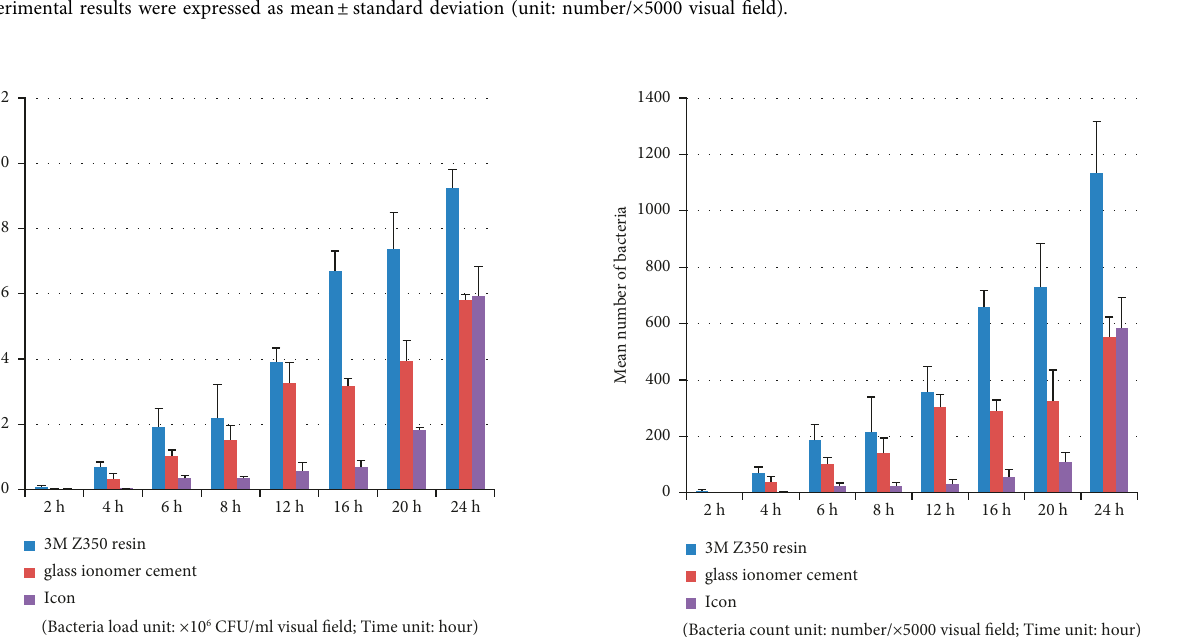
Figure 5: Actinomyces viscosus group(electron microscopy